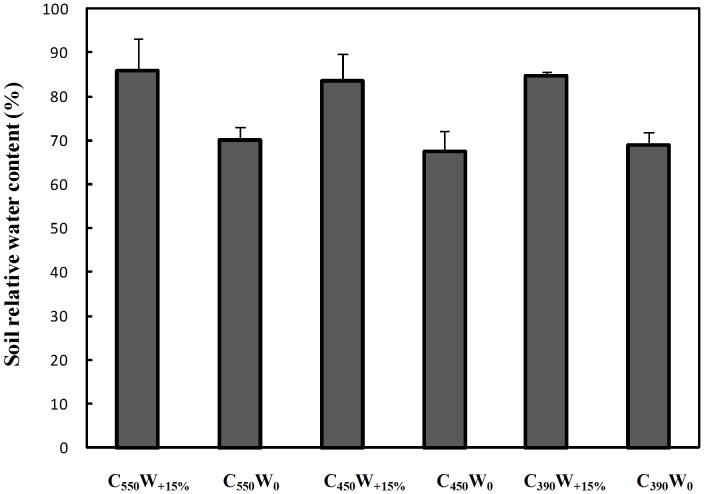
The relative soil moisture (means ± SD) (n = 3) in six treatments (C550W+15%, C550W0, C450W+15%, C450W0, C390W+15% and C390W0) in silking stage of maize under effects of elevated [CO2] and irrigation.